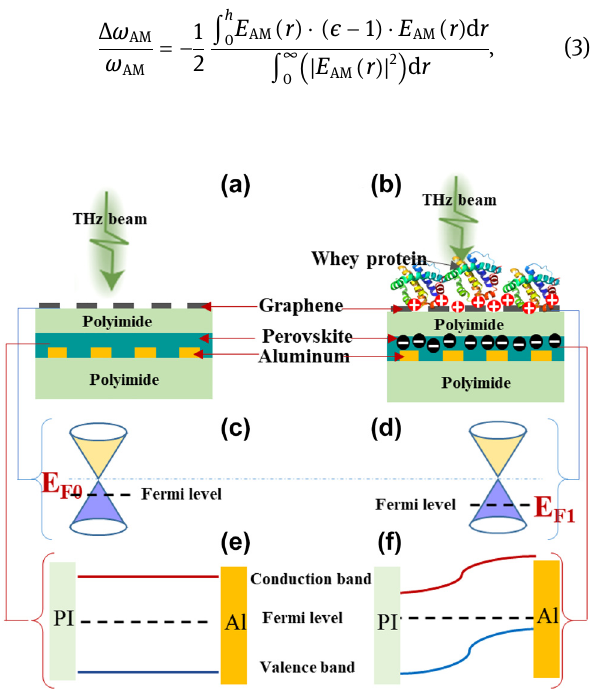
Figure 5: Schematic of the proposed sensing mechanism of